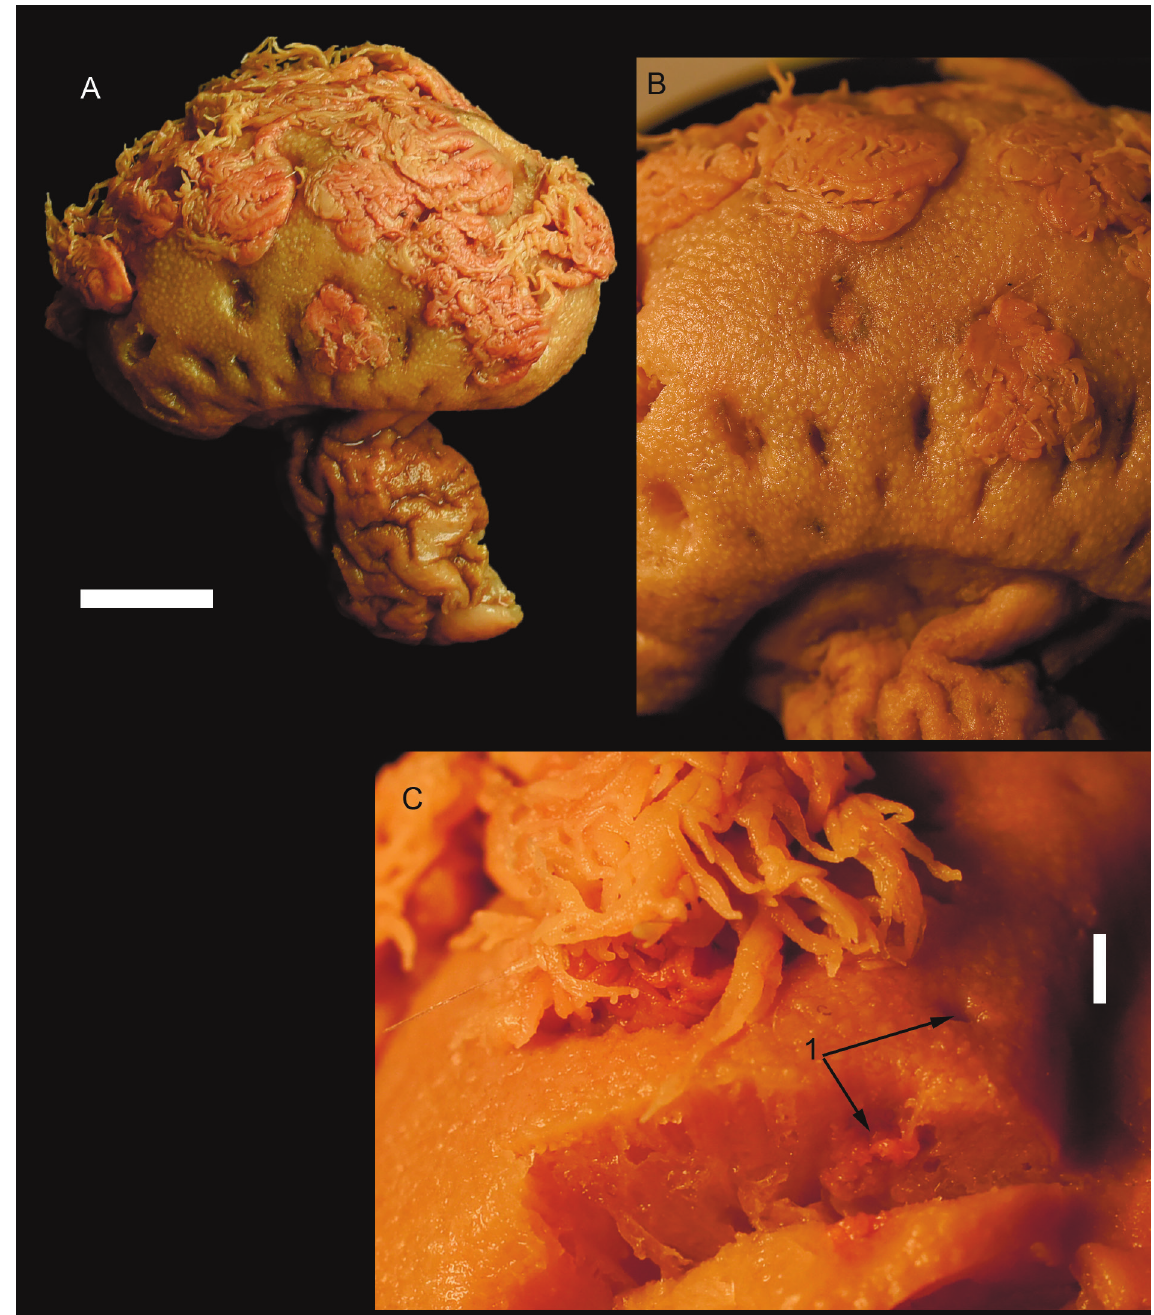
Fig. 6. Heteropolypus roseus sp. nov., holotype (MIMB 42495), Kurile Islands, Sea of Okhotsk. A . Whole specimen. B . Surface of the capitulum. C . Section of the capitulum; 1 = mesozooid. Scale bars: A = 10 mm; C = 1